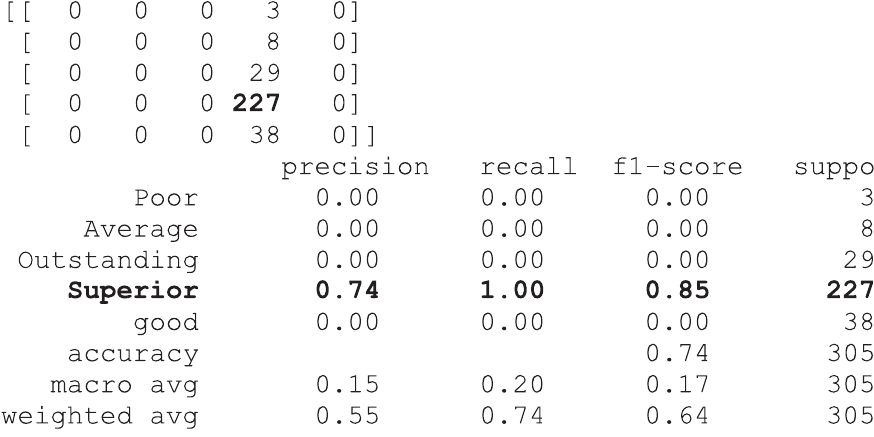
Figure 7: K-NN confusion matrix and accuracy results.